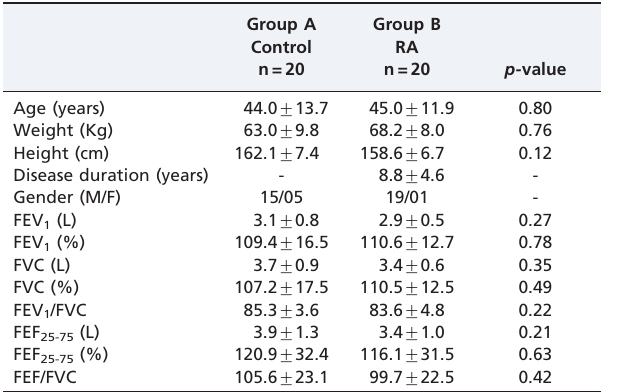
Table 1 - Biometric and spirometric characteristics of the studied groups.